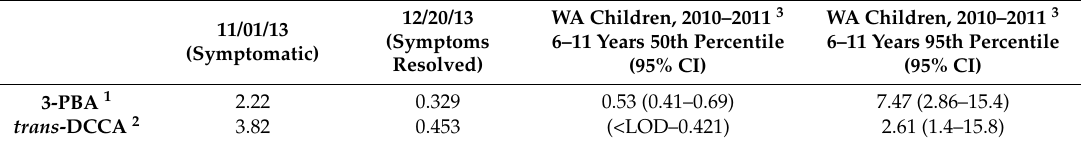
Table 2. Pyrethroid urinary metabolite concentrations ( µ g/g